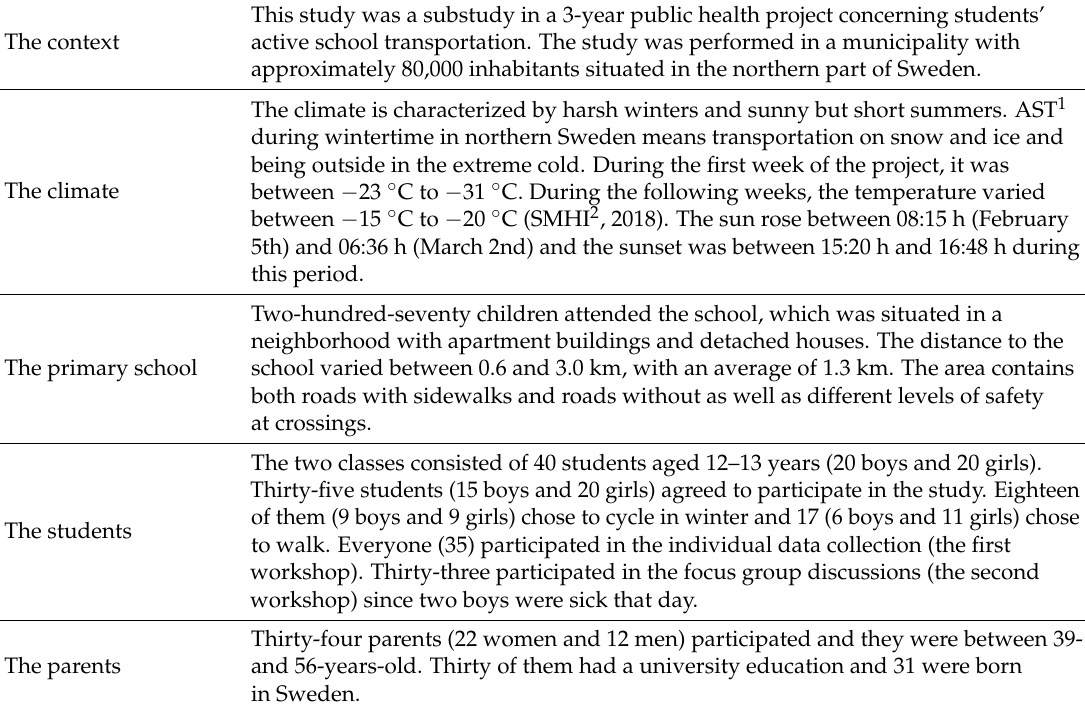
Table 1. Characteristics of the municipality, schoolchildren and parents who participated in the